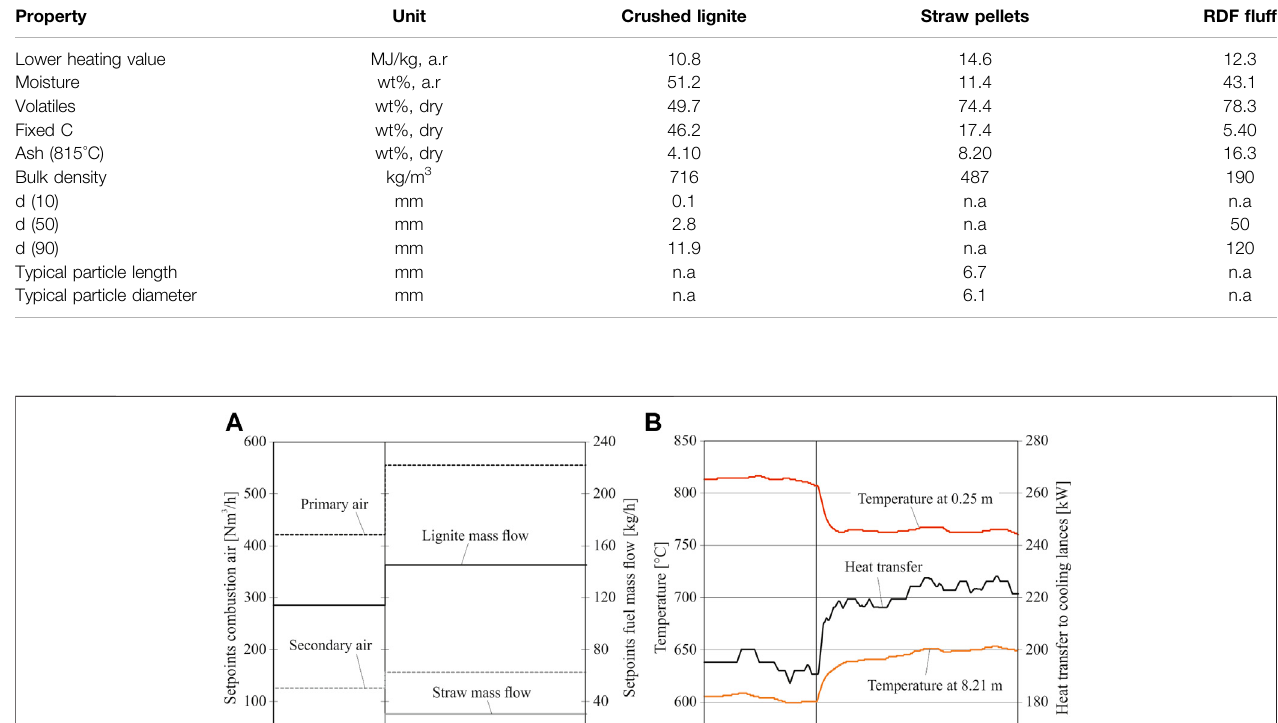
TABLE 3 | Fuel properties (a.r. (cid:2) as received, n.a. (cid:2) not analyzed). Property Unit Lower heating